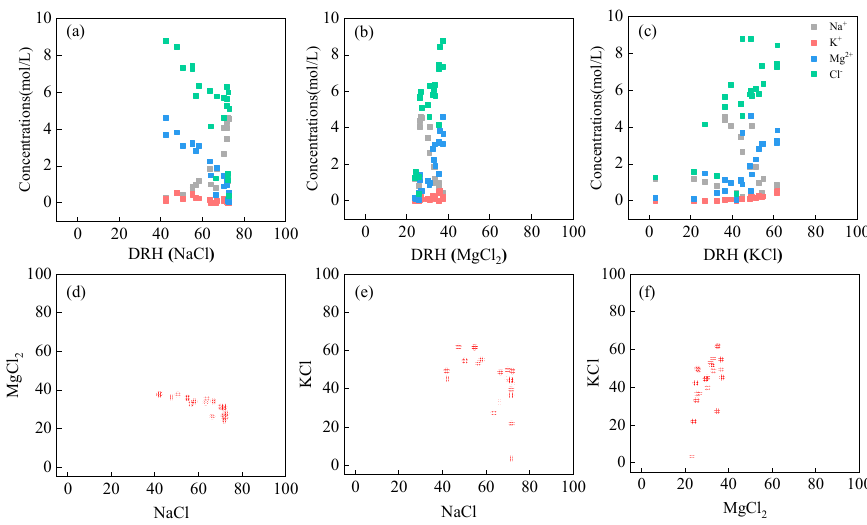
Figure 7. Figure 7. ( a – c ) Correlations of the DRHs and ionic concentration (moL/L) of four ions. ( d – f ) Correlations of the DRH value of three main salt components in brine samples.